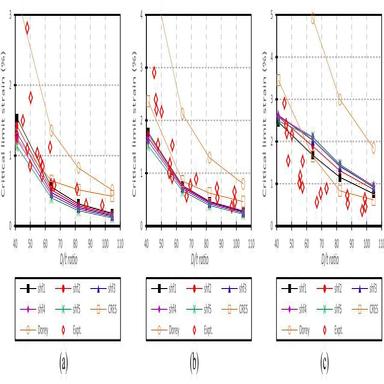
Comparison of CLS models with experimental test results for YPT X60 pipe: (a) fp = 0.0, (b) fp = 0.4, and (c) fp = 0.8.